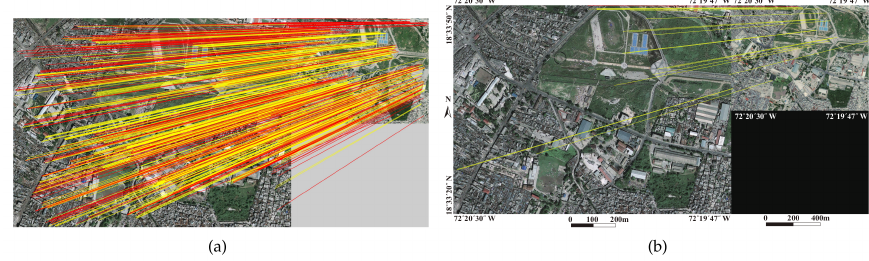
Figure 13. Matching results of image pair 5. ( a ) LJL; ( b ) Proposed.